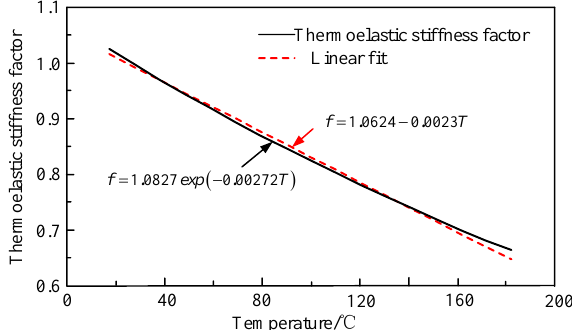
Figure 2. The thermoelastic sti ff ness coe ffi cient of an epoxy resin.